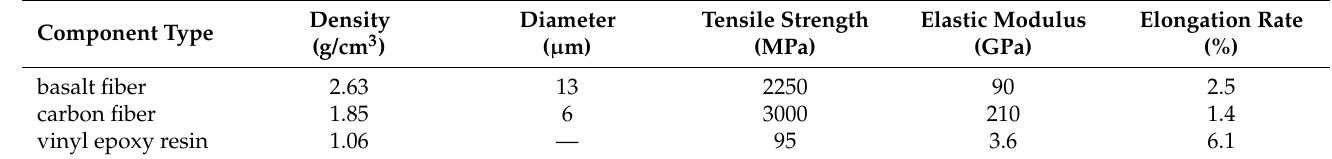
Table 2. Mechanical and physical properties of spiral components.